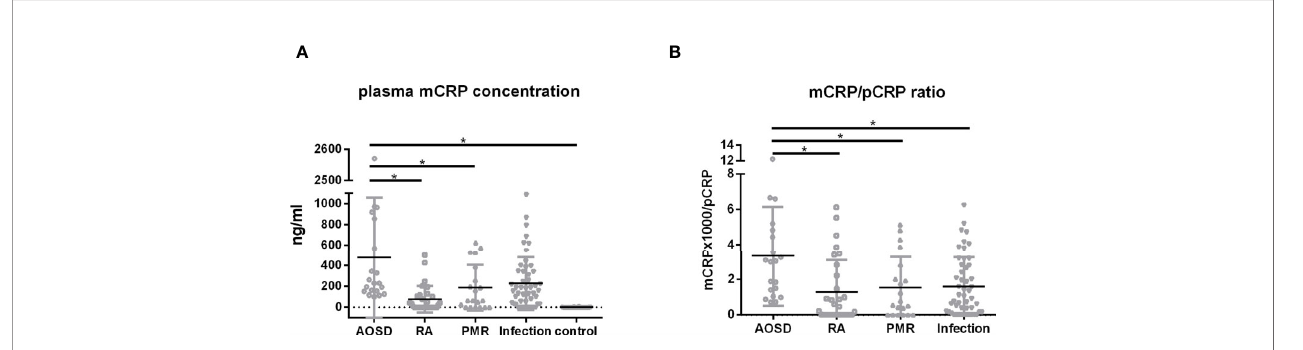
FIGURE 2 | Plasma mCRP concentration. Plasma mCRP concentration was measured in patients with AOSD (n = 20), PMR (n = 20), RA (n = 30), infection (n = 50), and in control subjects (n = 30) using the developed ELISA. (A) Plasma mCRP concentration in each group. (B) mCRP (×1,000)/pCRP ratio. Statistical analysis was